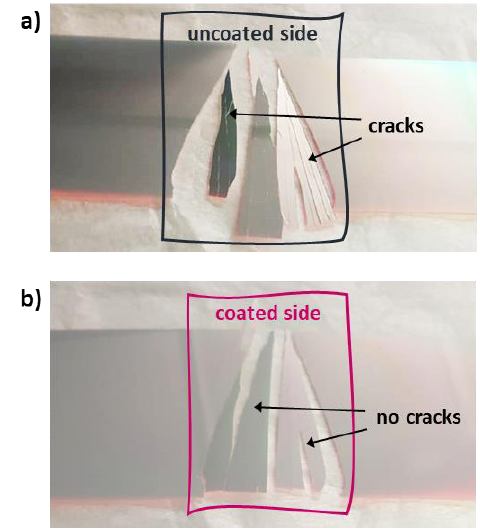
Fig. 2. Illustration photos of 1D photonic crystal after the breakage, showing a) uncoated and b) coated side of AS 87 eco ultrathin SCHOTT glass.